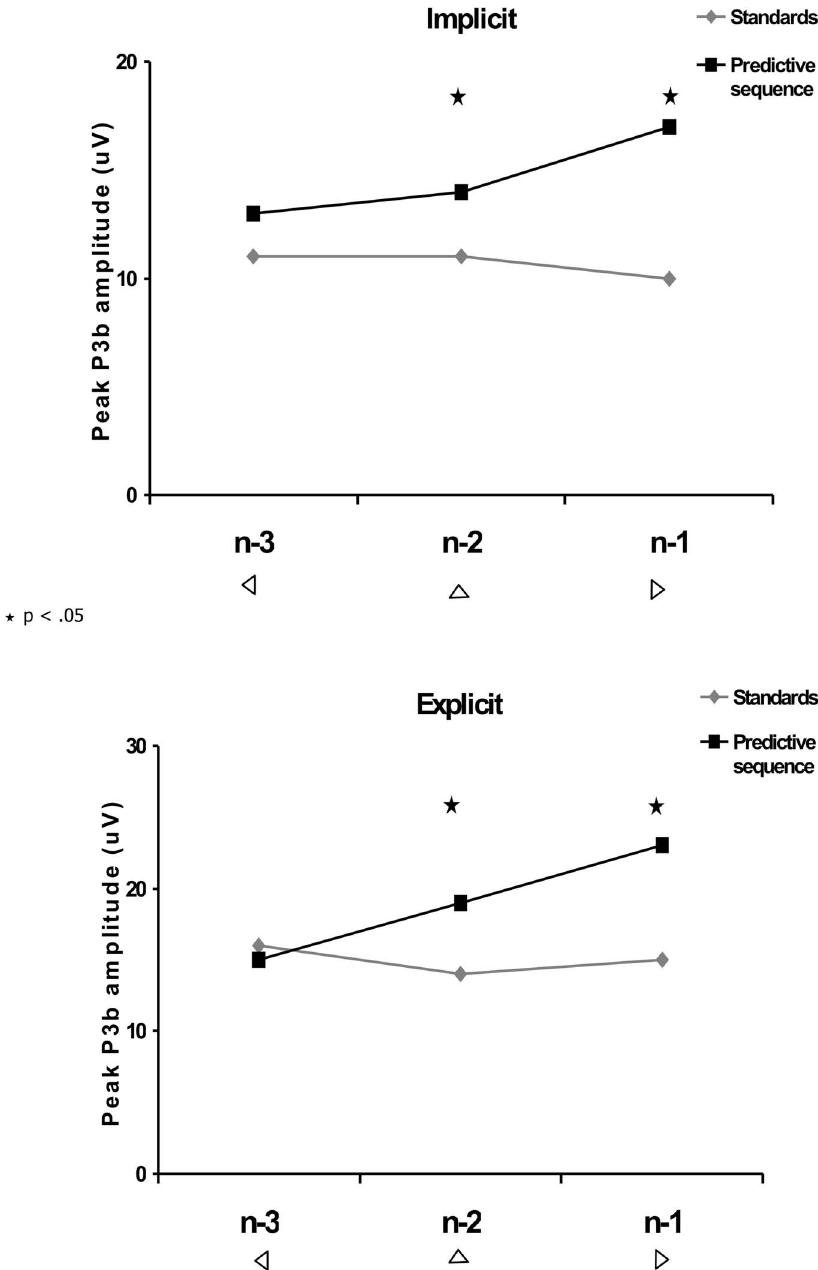
Figure 5. P3b amplitudes at CPz for the three stimuli comprising the predictive sequence. The first least-informative (n-3), the middle (n- 2), and last most informative (n-1); and for the corresponding three standards presented randomly (Standards) for implicit and explicit